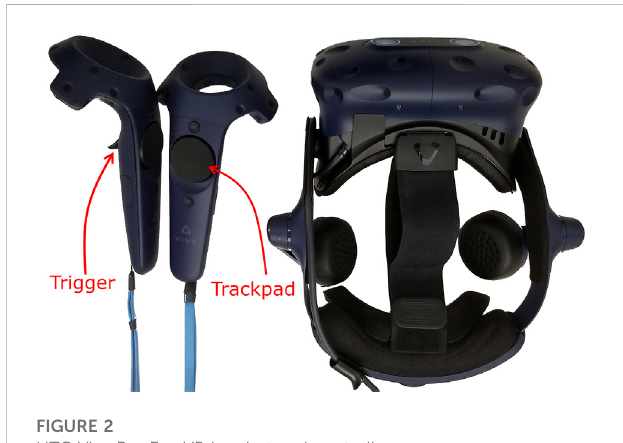
FIGURE 2 HTC Vive Pro Eye VR headset and controllers.